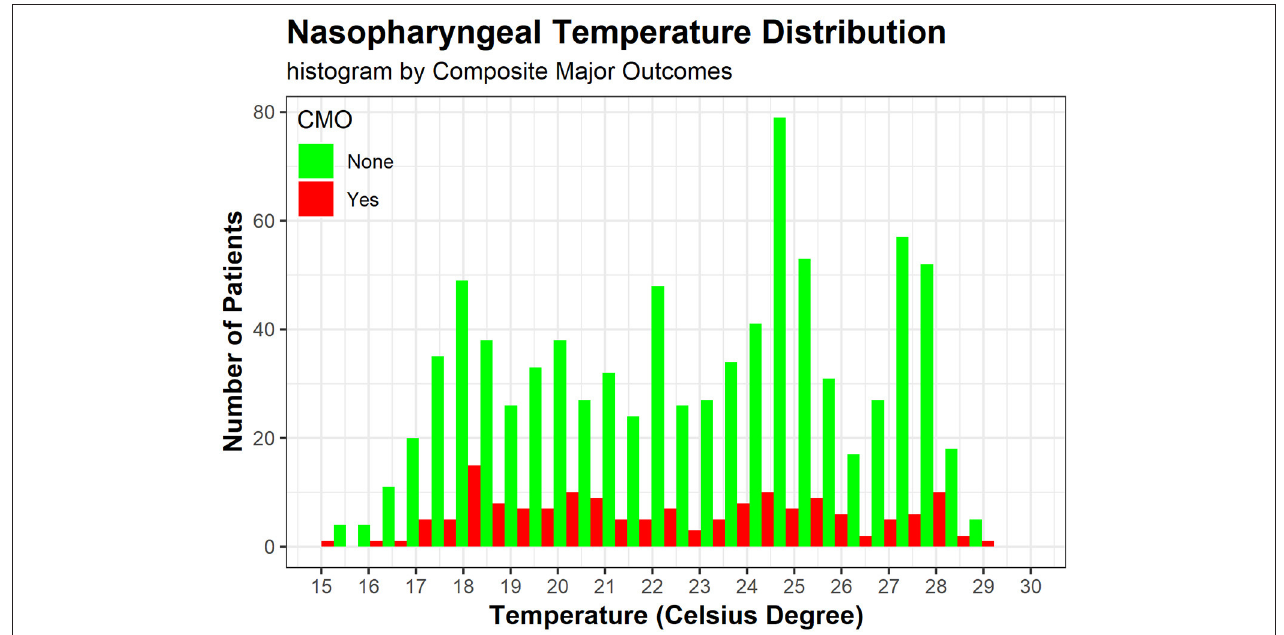
FIGURE 1 | The histogram shows nasopharyngeal temperature distribution by CMO (red) and not (green), both of which display a bimodal distribution around 18 and 25 ◦ C. CMO, composite major outcomes, including operative mortality, stroke, paraplegia, and CRRT (continuous renal replacement therapy).